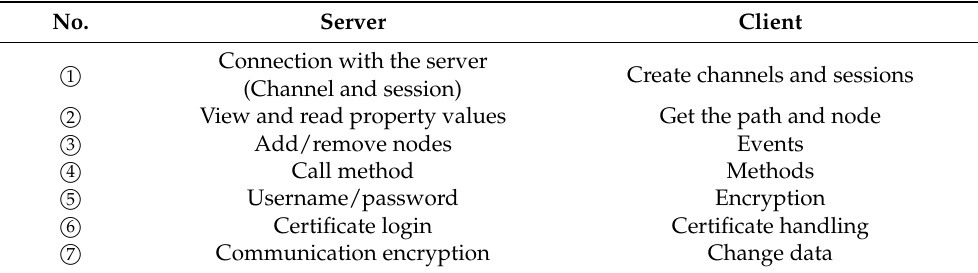
Table 11. Server–client requirement features.